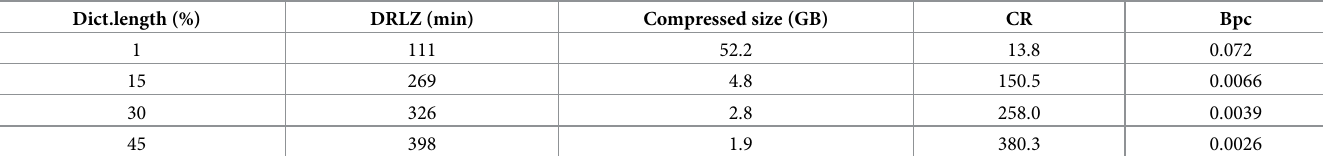
Table 1. Compressing a human pan-genome (n = 250) with increasing RLZ dictionary length (% of pan-genome length). Dict.length (%)